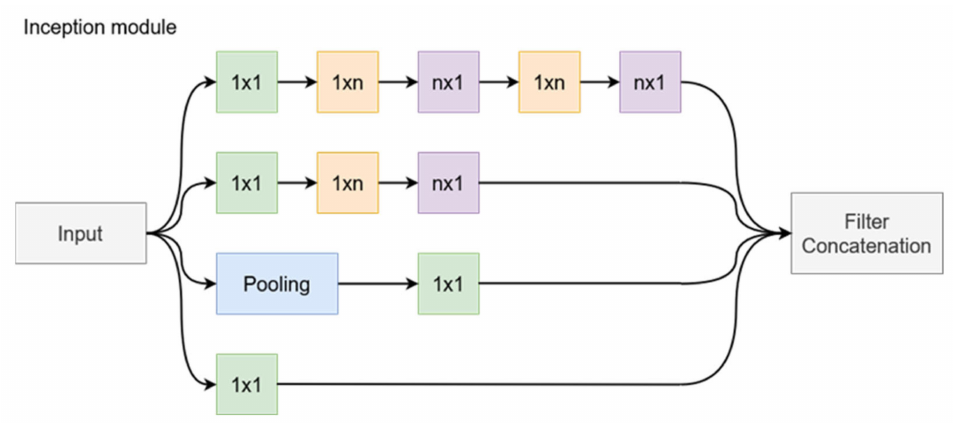
Figure 4. The general structure of an inception module after the factorization of an n × n